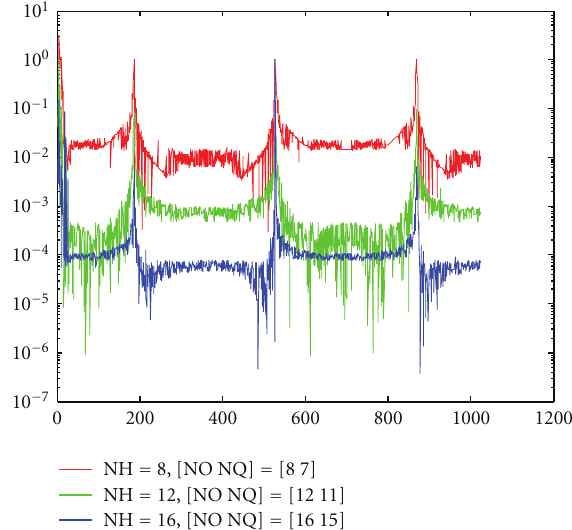
Figure 12: Relative error, N = 32. Three bitwidth cases.